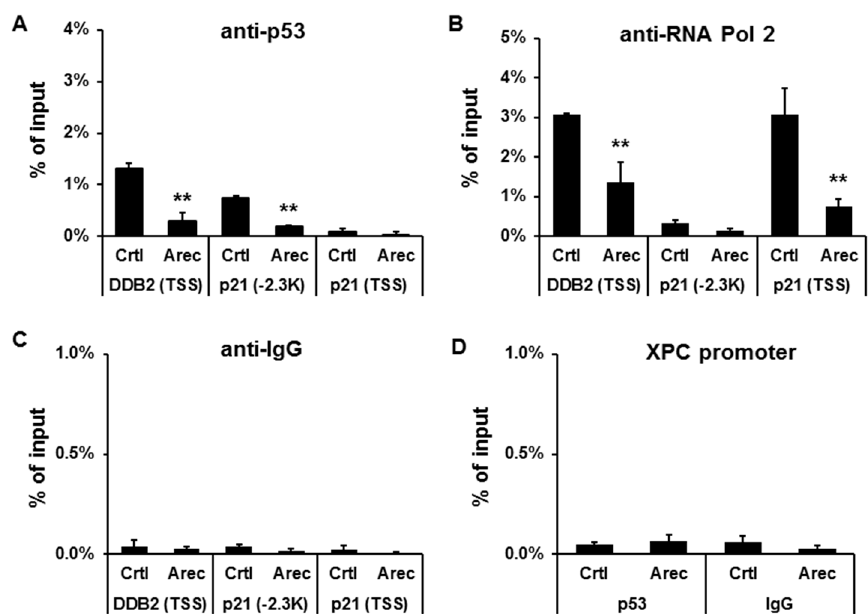
Figure 2. Arecoline inhibits the recruitment of p53 and RNA polymerase II to the promoters of DDB2 and p21 Cip1 ( CDKN1A ) in vivo. The HEp-2 cells were treated with arecoline (0.3 mM) or vehicle (H 2 O) for 24 h and then were harvested for chromatin immunoprecipitation assays using anti-p53 ( A ), anti-RNA polymerase II ( B ), and control IgG ( C ) antibodies followed by quantitative PCR. The PCR amplicons cover the p53-binding sites on the DDB2 (around the transcription start site, TSS) and p21 Cip1 (at 2.3 kilobase upstream to TSS) promoters. ( D ) Chromatin immunoprecipitation assays show no specific binding of p53 and control IgG to the XPC promoter. Data are shown as mean ± standard deviation ( n = 3). Ctrl, H 2 O; Arec, arecoline. ** p < 0.01 versus control.